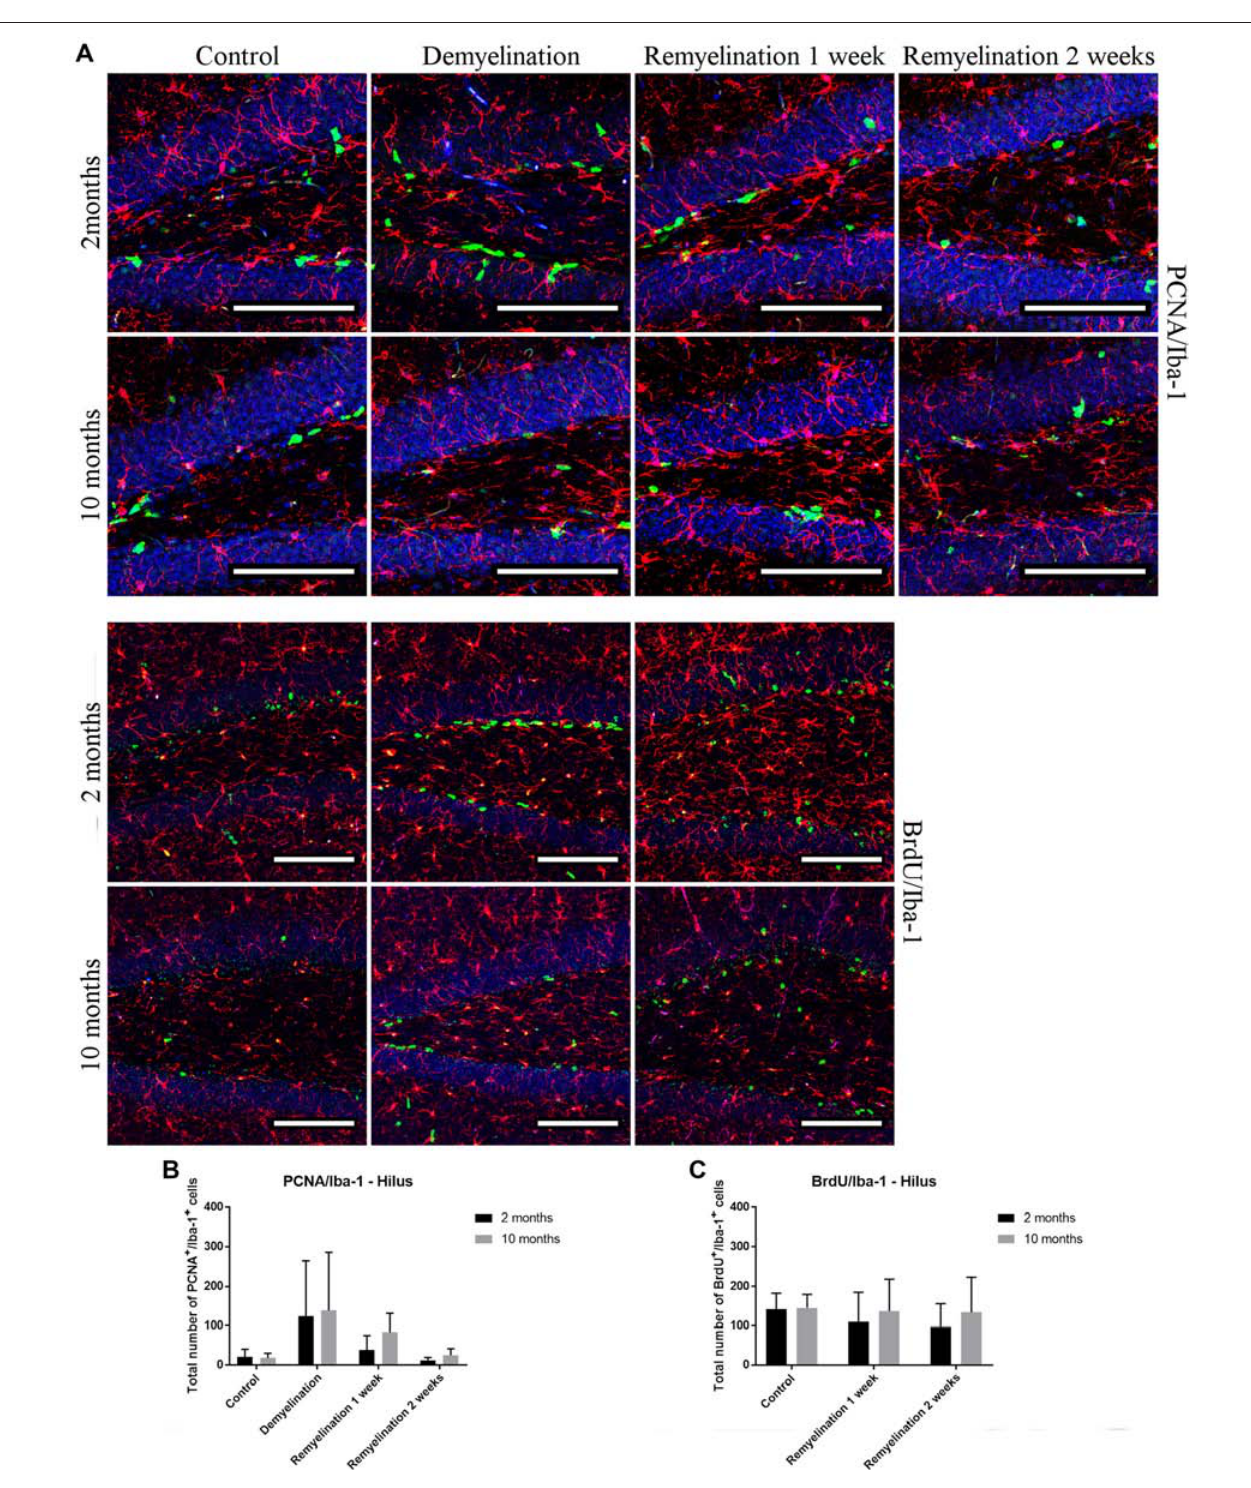
FIGURE 11 | No significant changes in numbers of proliferating microglia (PCNA + and BrdU + ) in the hilus of the hippocampal DG. (A) Proliferating cell nuclear antigen (PCNA; green) and Iba-1 (red) labeling. Cell nuclei are stained with DAPI (blue). (B) Bromodeoxyuridine (BrdU; green) and Iba-1 (red) labeling. Cell nuclei are stained with DAPI (blue). (C) No significant effects on the number of proliferating PCNA + microglia was observed. (D) The number of Iba-1 + BrdU + cells was also not affected during de- or remyelination in either age group. Values are shown as means + SD ( n = 6 per group). Statistical significance was evaluated using a two-way ANOVA and a Tukey’s post hoc test. Bars: (A) 100 µ